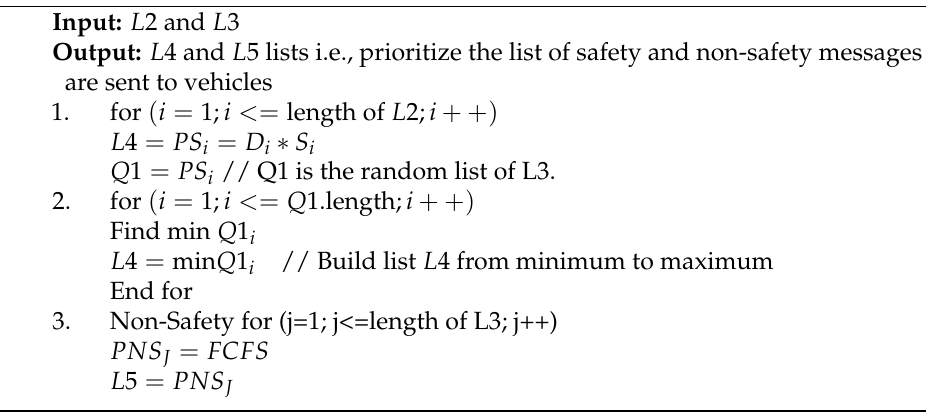
Algorithm 3: Prioritization of Safety and Non-Safety List (i.e., L 2 & L